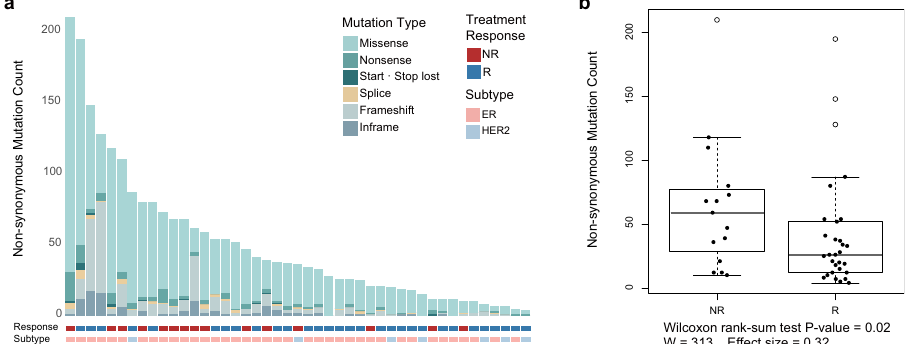
Fig. 3 Exomic landscape of all patients and the comparison of non-synonymous mutation burden between responders and non-responders. a Exomic landscape of all patients according to response, molecular subtype, and nonsynonymous mutations. The 13 samples represent the top 30 percent of the nonsynonymous mutational burden and consisted of eight samples from the 15 nonresponders and fi ve samples from the 30 responders. b Comparison of nonsynonymous mutational burden between responders and non-responders. P values were calculated by the Wilcox rank-sum test (NR non-responder, R